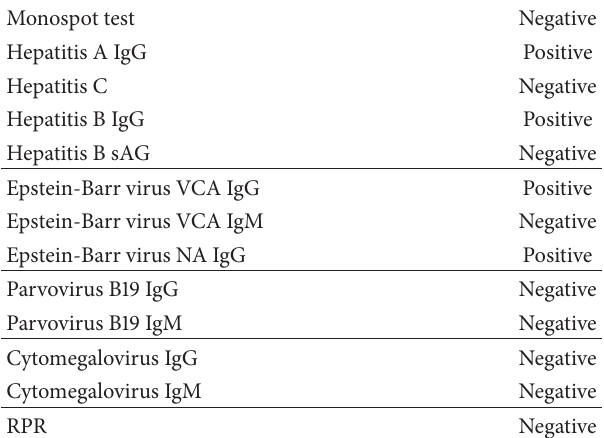
Table 1: Summary of infectious work-up.